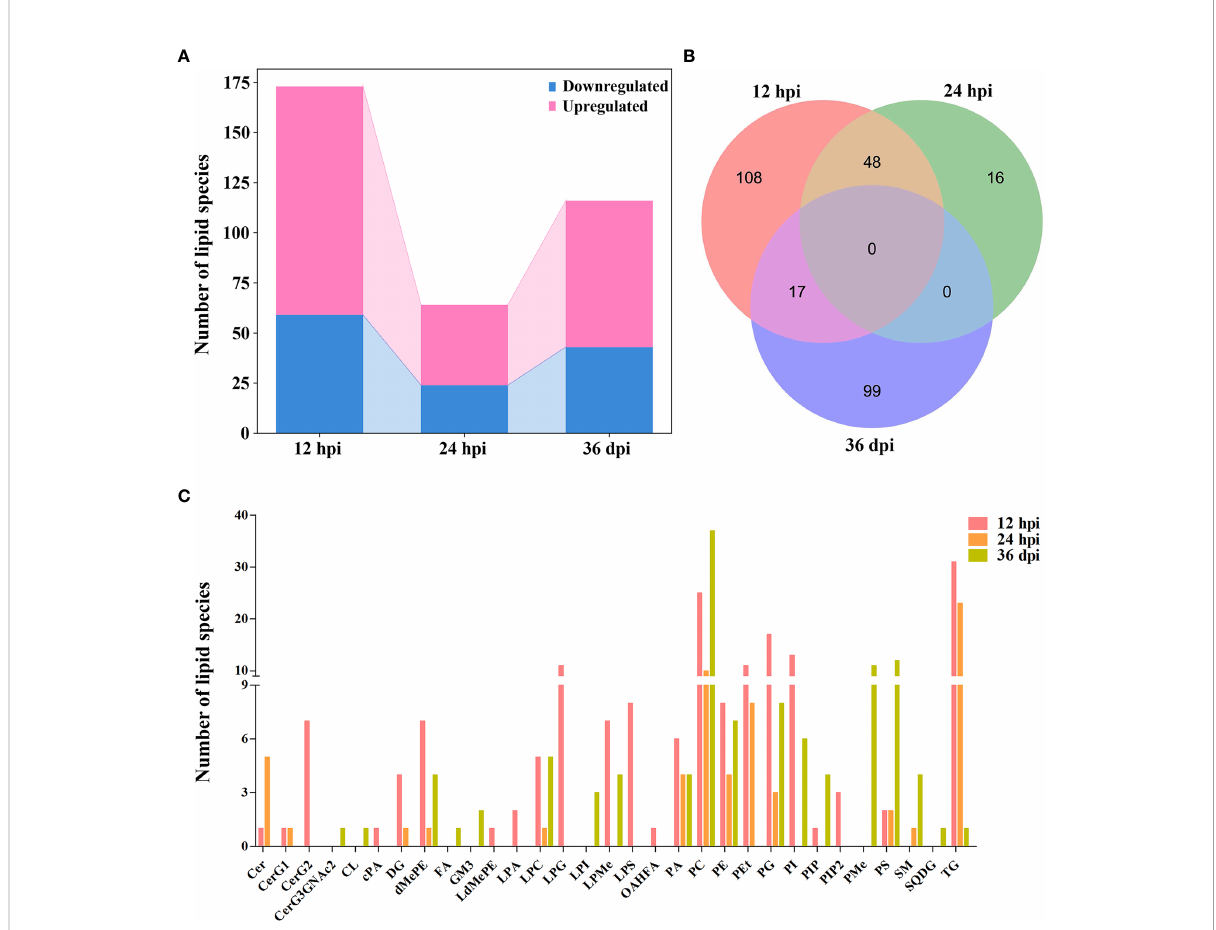
FIGURE 3 Comparison of lipids with differential abundance in the liver of beagle dogs infected with 300 embryonated Toxocara canis eggs at 12 hpi, 24 hpi, and 36 dpi. (A) Stacked bar chart shows the numbers of lipids with differential abundance at the three infection stages. (B) Venn diagram shows the common and unique differential lipid species among the three infection stages. (C) The number of lipid species with differential abundance in each lipid subclass at 12 hpi, 24 hpi, and 36